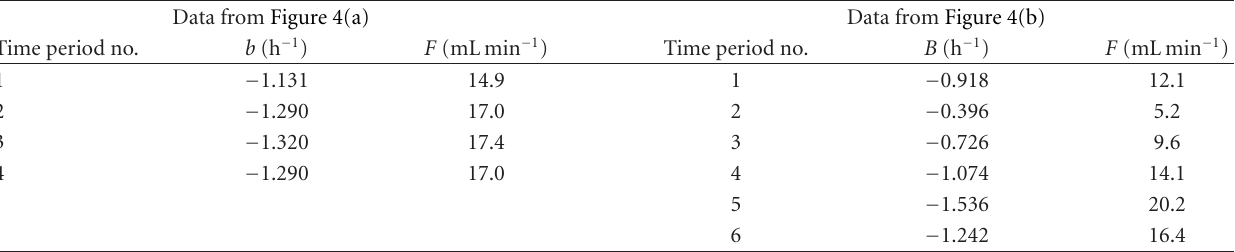
Table 2: Mytilus edulis . Slope ( b ) of linear regression lines shown in Figures 4(a) and 4(b) along with the estimated individual filtration rate ( F = b × V/n ) according to (2). Data from Figure 4(a) Data from Figure 4(b) Time period no. b (h − 1 ) F (mLmin − 1 ) Time period